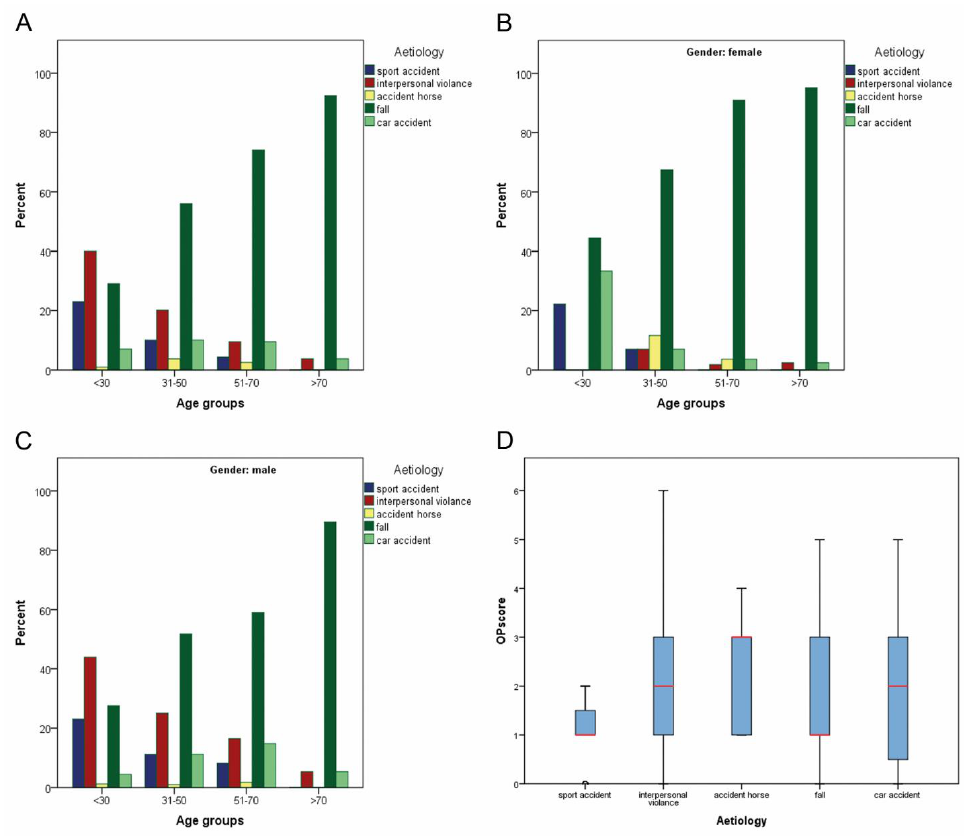
Figure 1. Overview of all aetiologies for surgically treated zygomatico-maxillary complex fractures within four age groups without ( A ) and with consideration of genders ( B , C ). Fisher exact testing revealed a significant difference ( A – C , each p < 0.001) for the distribution of aetiologies within the age groups. Kruskal – Wallis testing showed a significant influence of the aetiology on the Clinical Score ( D , p = 0.038). Table 3. Aetiology of 461 retrospectively analysed cases of isolated unilateral zygomatico-orbital